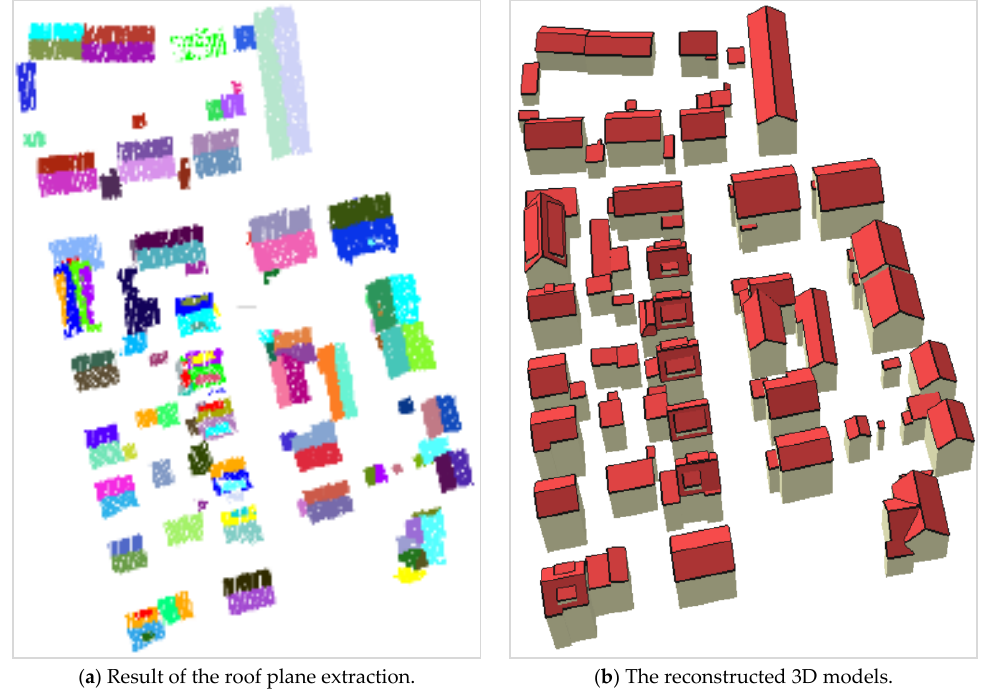
Figure 12. Results of the plane segmentation and 3D reconstruction (Vaihinge, Area 3).